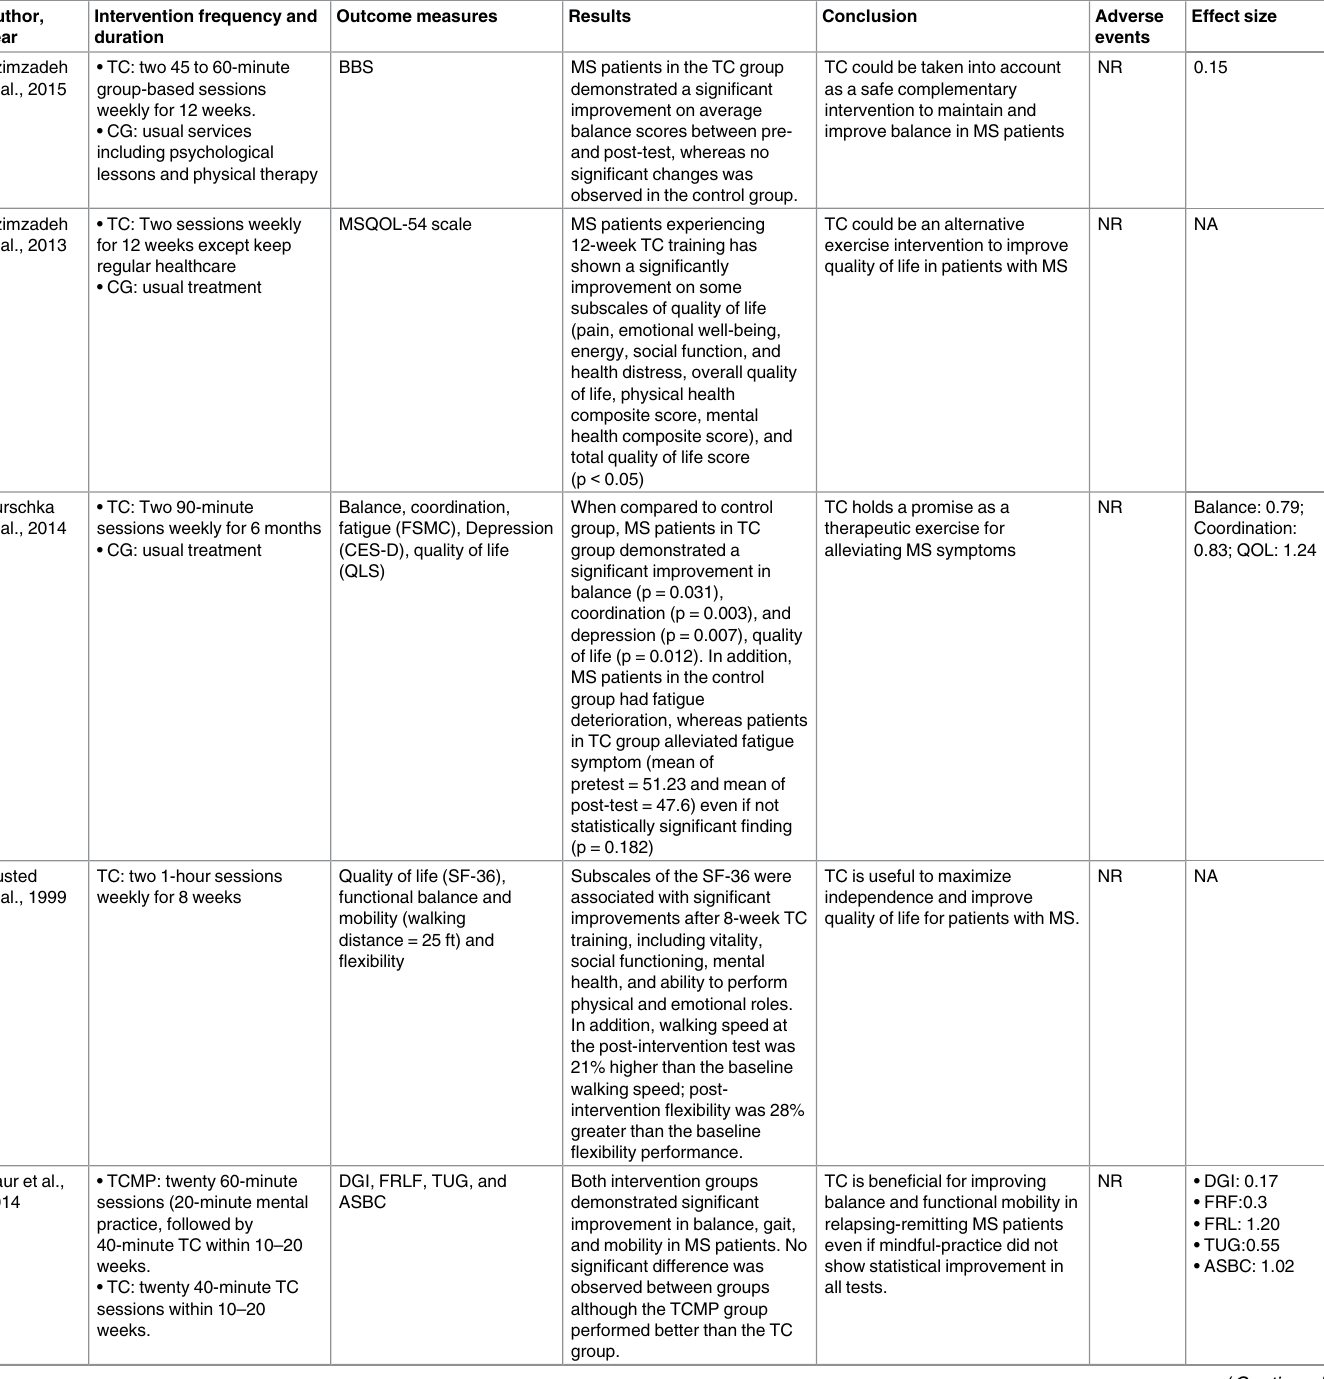
Table 4. Summaryof Tai Chi for patients with multiple sclerosis (intervention frequency and duration, outcome measures,results, conclusion, and adverse